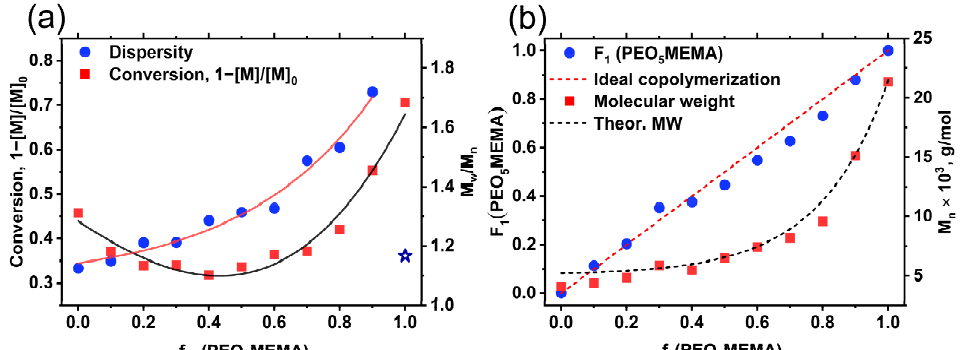
Figure 4. Monomer conversion and dispersity ( M w /M n ) ( a ); number molecular weight ( M n ) and PEO 5 MEMA amount in final composition ( F 1 ) of p (St- co -PEO 5 MEMA) copolymers ( b ) as a function of PEO 5 MEMA amount in initial molar feed (f 1 ) of polymerization mixture. Black and red dashed lines in Figure 5b represent the theoretical molecular weights of p (St- co -PEO 5 MEMA) copolymers and the monomer distribution in case of ideal copolymerization, respectively.